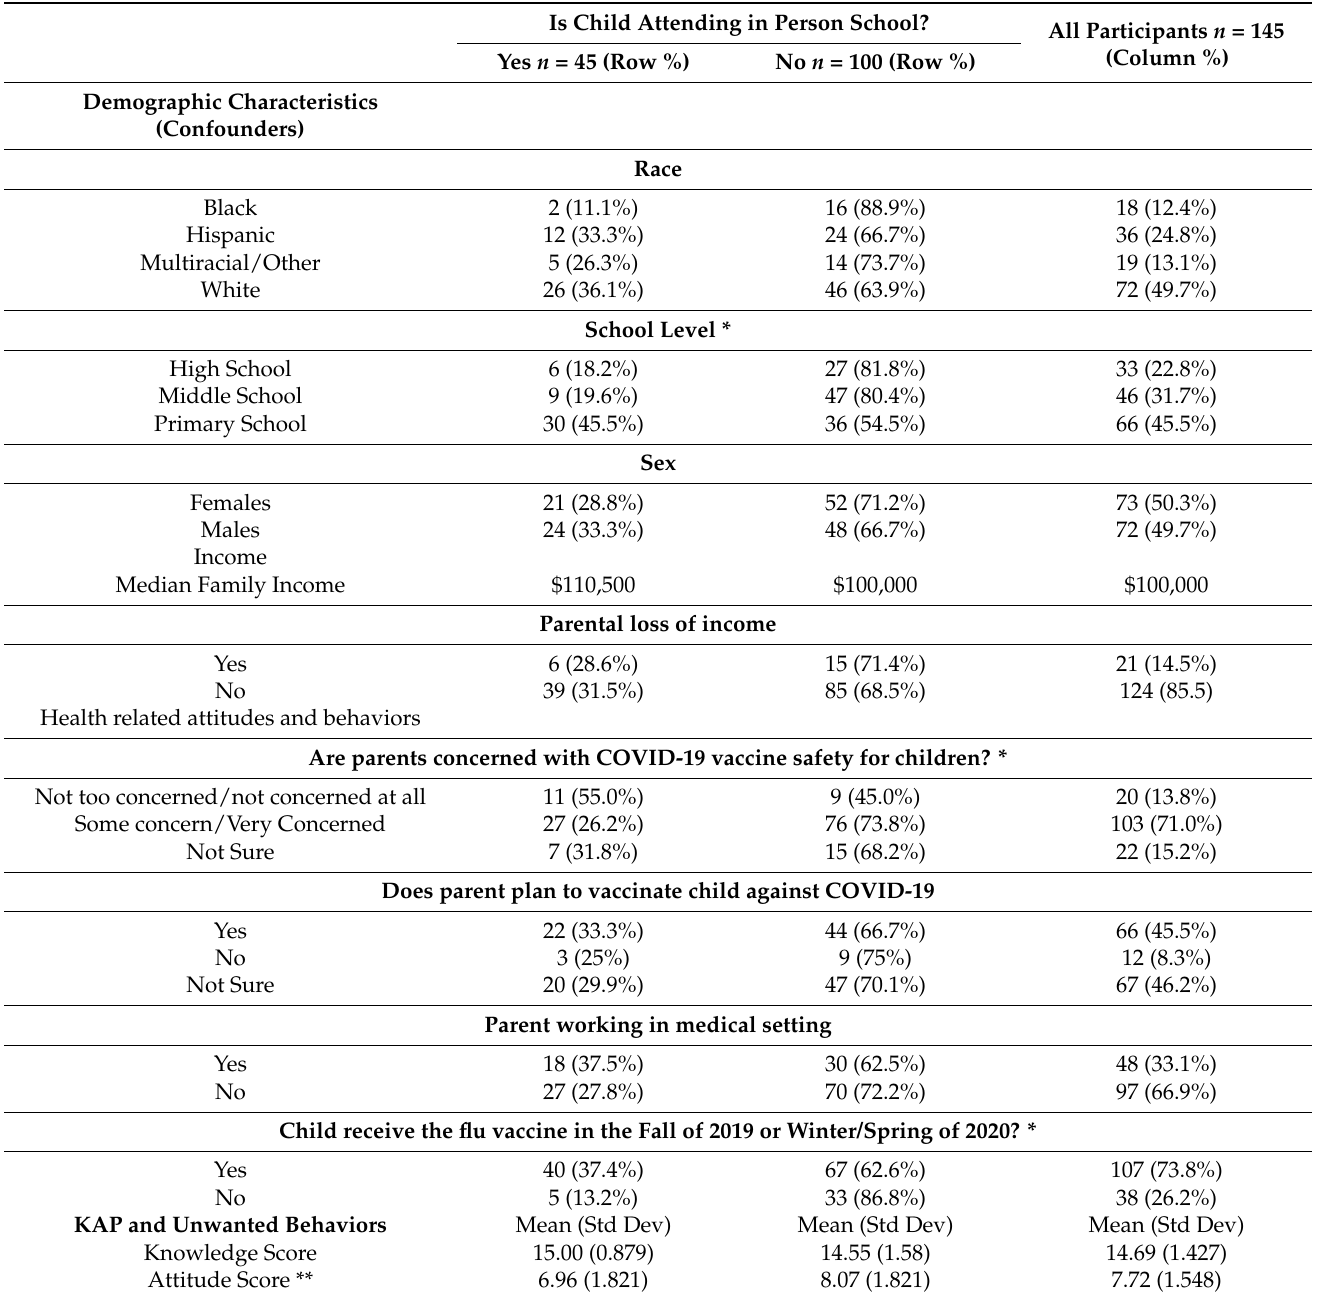
Table 1. Demographic Characteristics of the Study and Variables of Interest by Learning Environment and for Total Study